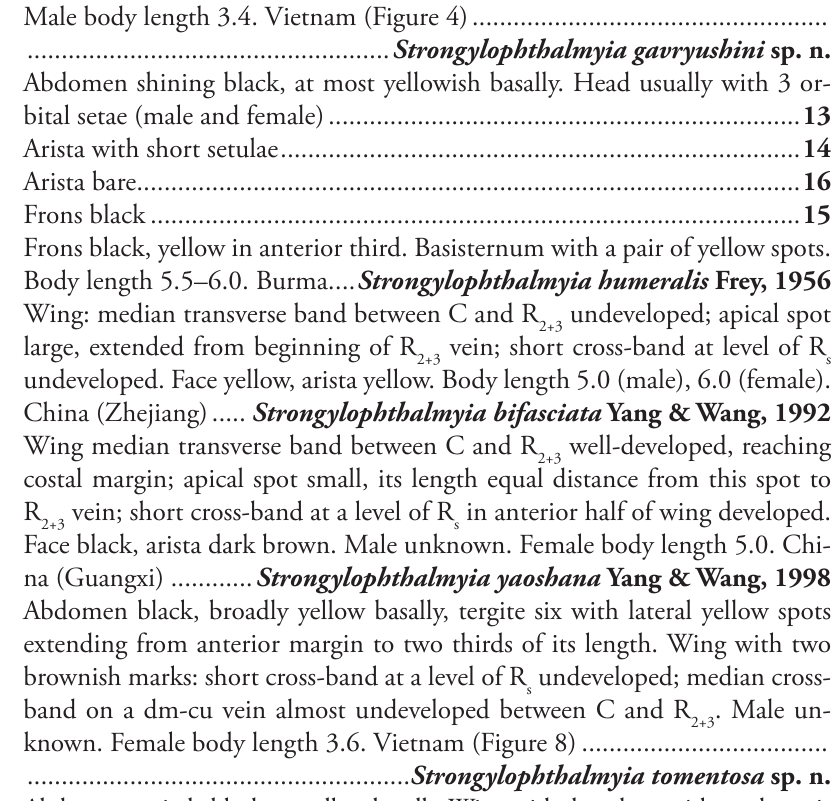
– Abdomen shining black, at most yellowish basally. Head usually with 3 or-